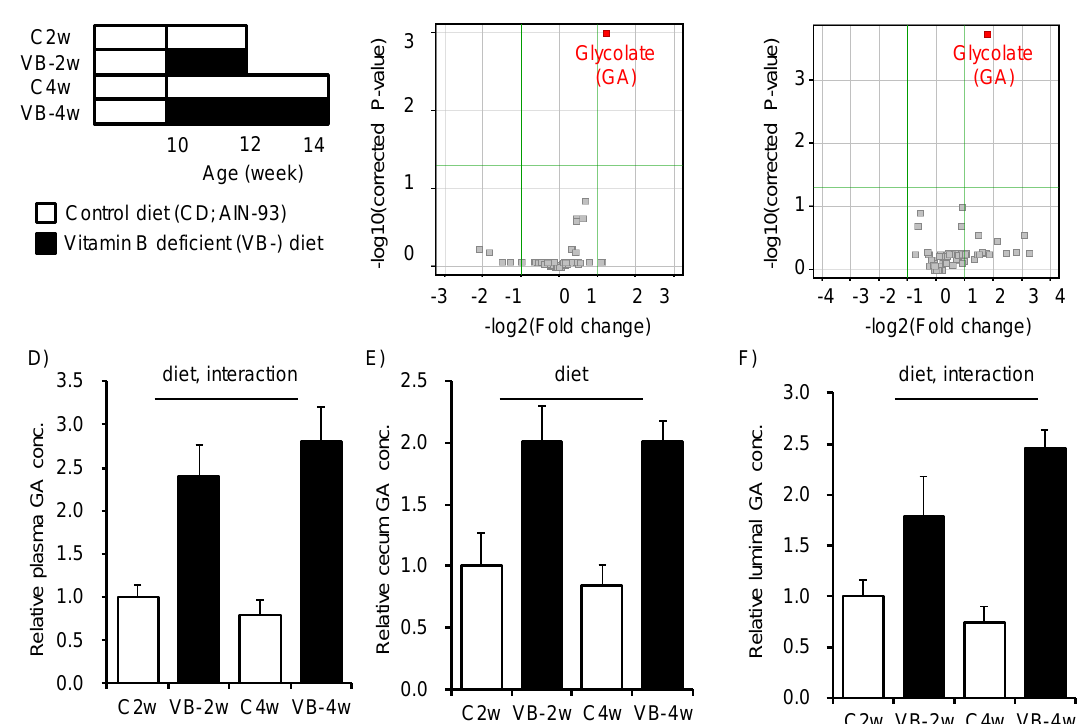
Figure 1. Feeding of diet deficient in vitamin B 2 , B 6 , B 12 , and folic acid induced accumulation of glycolate in plasma, cecum, and luminal content of the cecum. ( A ) Study design for Experiment 1. Mice were fed a control diet (C: AIN93-G) or a diet deficient in vitamin B 2 , B 6 , B 12 , and folic acid (VB-) diet for 2 or 4 weeks. ( B , C ) Volcano plots of 77 metabolites in plasma from mice fed either VB- or control diet for ( B ) 2 or ( C ) 4 weeks. The glycolate (GA) concentration changed significantly in both the 2- and 4-week feeding groups. ( D – F ) Relative concentration of glycolate in ( D ) plasma, ( E ) cecum, and ( F ) luminal content for the four groups ( n = 4–5). Two-way ANOVA was used to determine the effect of diet, time, and the interaction of diet and time; p < 0.05.